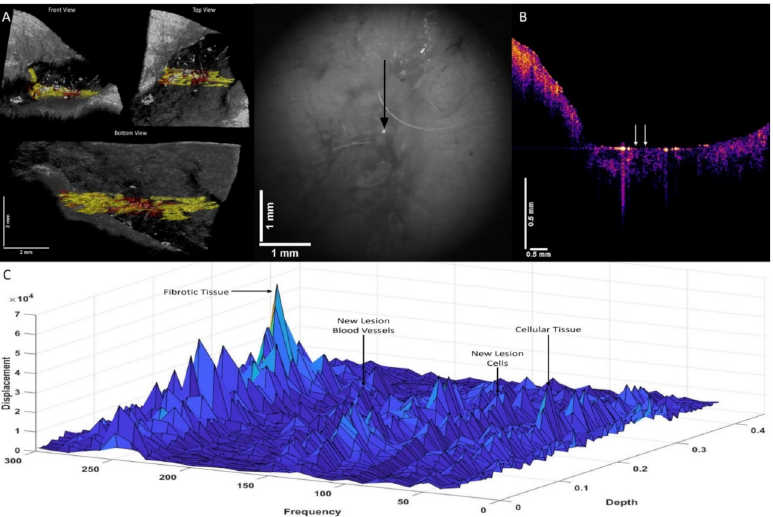
Figure 6. Three-dimensional color-coded OCT images of a squamous cell carcinoma (SCC). ( A ) illus- trates the location of new cells (80 Hz) and new lesion blood vessels (130 Hz) (red), and fibrotic tissue (260 Hz) (yellow), as well as a camera image of the lesion showing where the VOCT measurements were made (center). ( B ) shows a cross-section of OCT image of the SCC lesion. ( C ) A 3D plot of weighted displacement versus frequency and depth showing the location of skin cells (50 Hz), new cells (80 Hz), papillary collagen (100 Hz), new lesion blood vessels (130 Hz), and fibrotic tissue (260 Hz). Note that only the peaks at about 50 Hz (cells), 100 Hz (dermal collagen), and 150 Hz (blood vessels) are found in normal skin. Note that the relationship between new cells and fibrotic tissue are found in both islands and linear